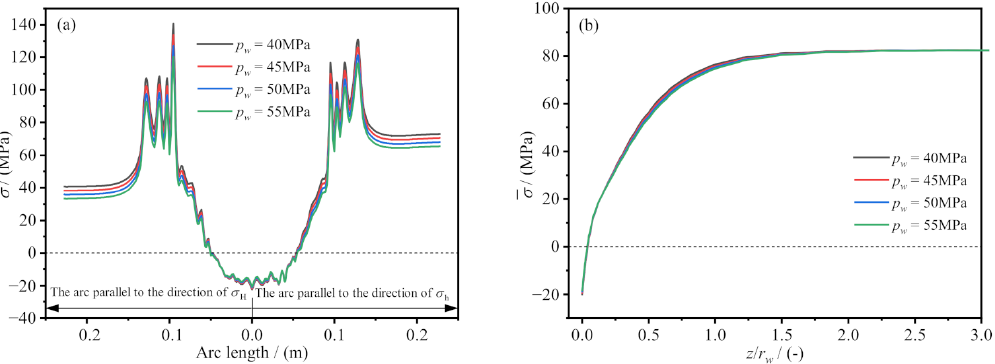
Figure 11. Average effective stress of the bottomhole rocks under different wellbore pressure condi- tions. ( a ) The arc parallel to the direction of σ H and σ h ; ( b ) The line along the axis of the